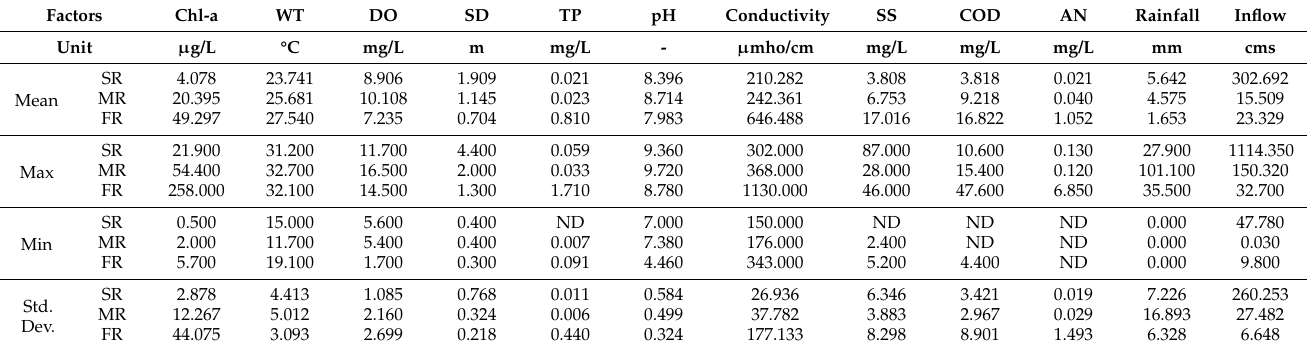
Table 2. Descriptive statistics from the Shimen, Mingde, and Fongshan Reservoir